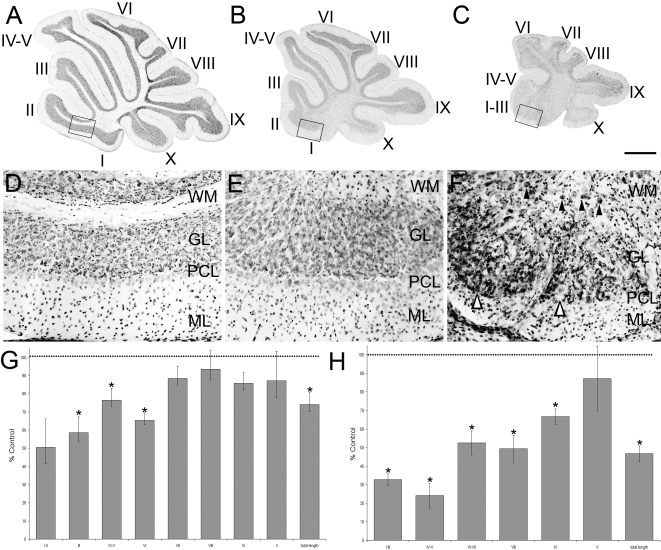
Cresyl violet staining reveals that the cerebellar cortex of Apoer2 and Vldlr mutants is abnormal.Sagittal sections through the medial cerebellum of adult wild type (A, D), Apoer2 (B, E) or Vldlr− (C, F) null animals indicate that mutant cerebella are smaller and have fewer lobules when compared to wild type mice. Higher-power views reveal that a trilaminar structure is present in both mutants and wild type (D–F) consisting of an outer molecular layer (ML), Purkinje cell layer (PCL) and inner granule cell layer (GL). White matter tracts (WM) can also be observed in each animal. High magnification views of the Vldlr null cerebellum reveal the presence of Purkinje cell-sized somata in the granular layer and white matter (e.g. black arrowheads–F) as well as gaps in the Purkinje cell layer (white arrowheads–F). Measurements of the length of lobules in Apoer2 null (G) or Vldlr null (H) cerebella are expressed as a percentage of the length in wild-type littermates. Length measurements reveal a reduction in several areas of each mutant cerebellum. These reductions are most prominent in the anterior cerebellum of both mutants. Error bars on the graph depict SEM. Dotted line indicates the length of the equivalent lobule in wild type animals. Scale bar = 1 mm for A–C and 125 µm for D–F. * indicates p<0.05 as determined by one way ANOVA.